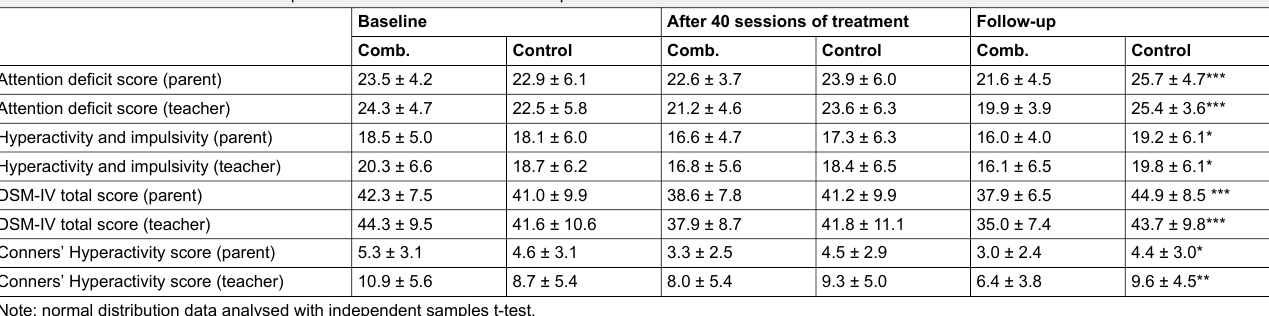
Table 2: DSM-IV ADHD and Conners’ questionnaire results at various time points.